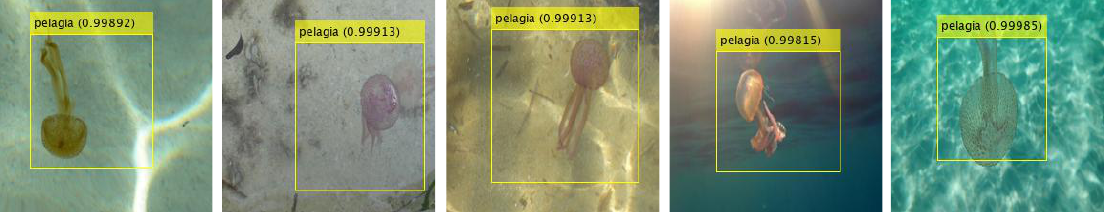
Figure 6. Output by classification model 5 for Pelagia noctiluca